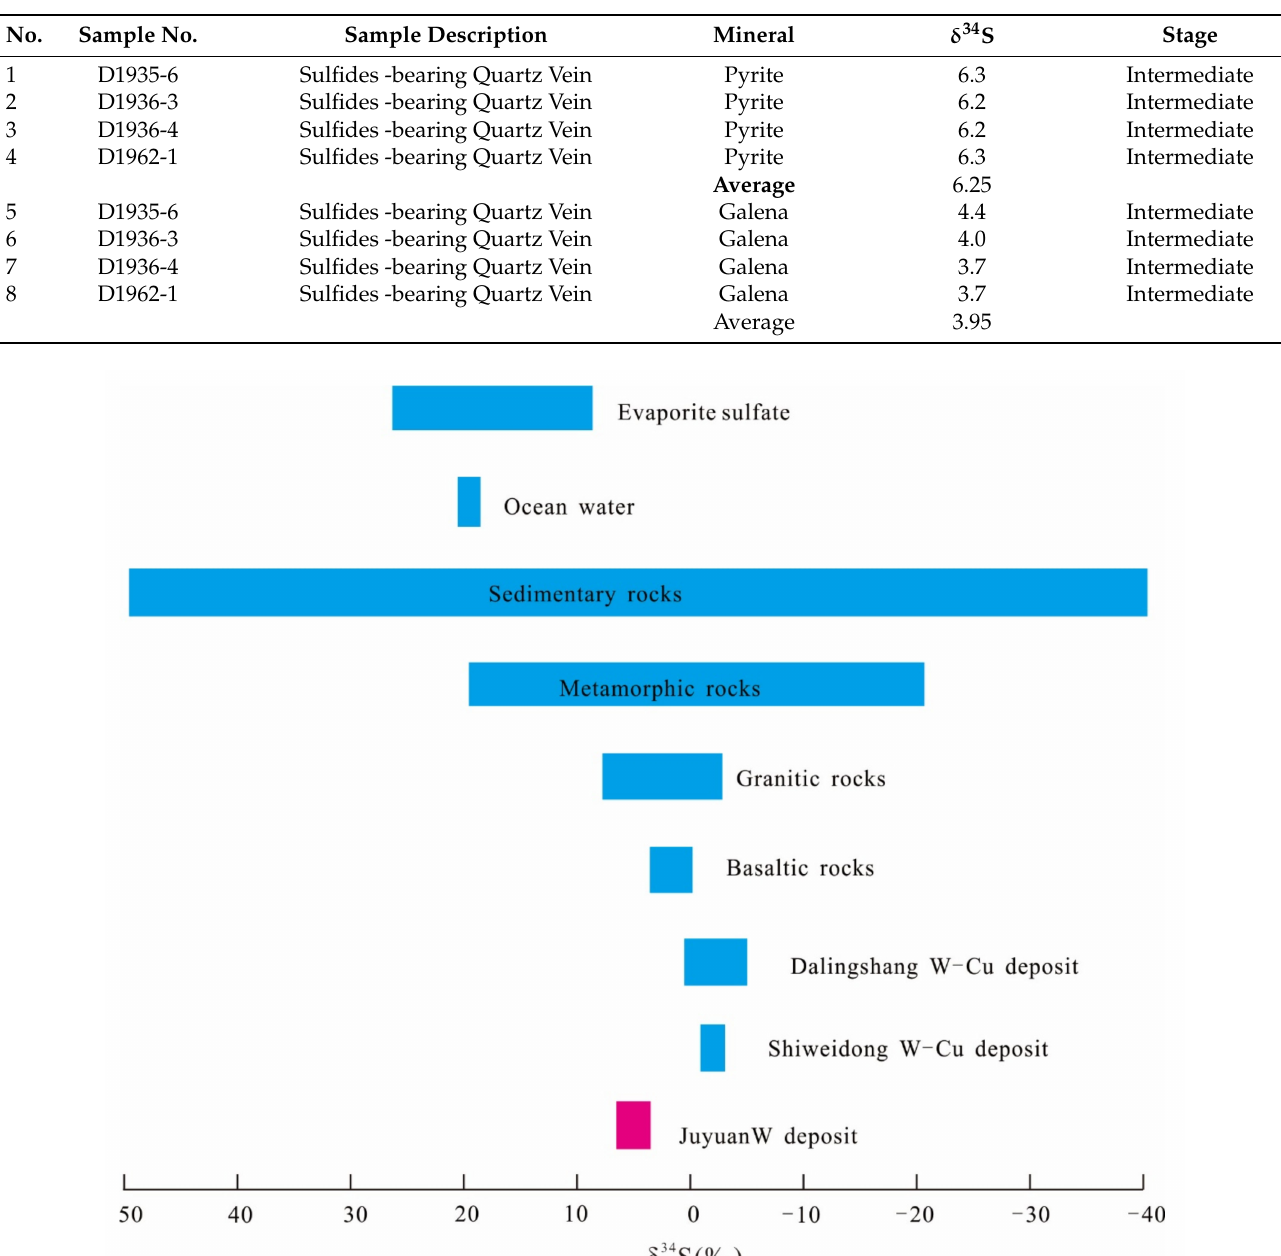
Table 3. The δ 34 S values of ores and rocks at the Juyuan tungsten deposit.